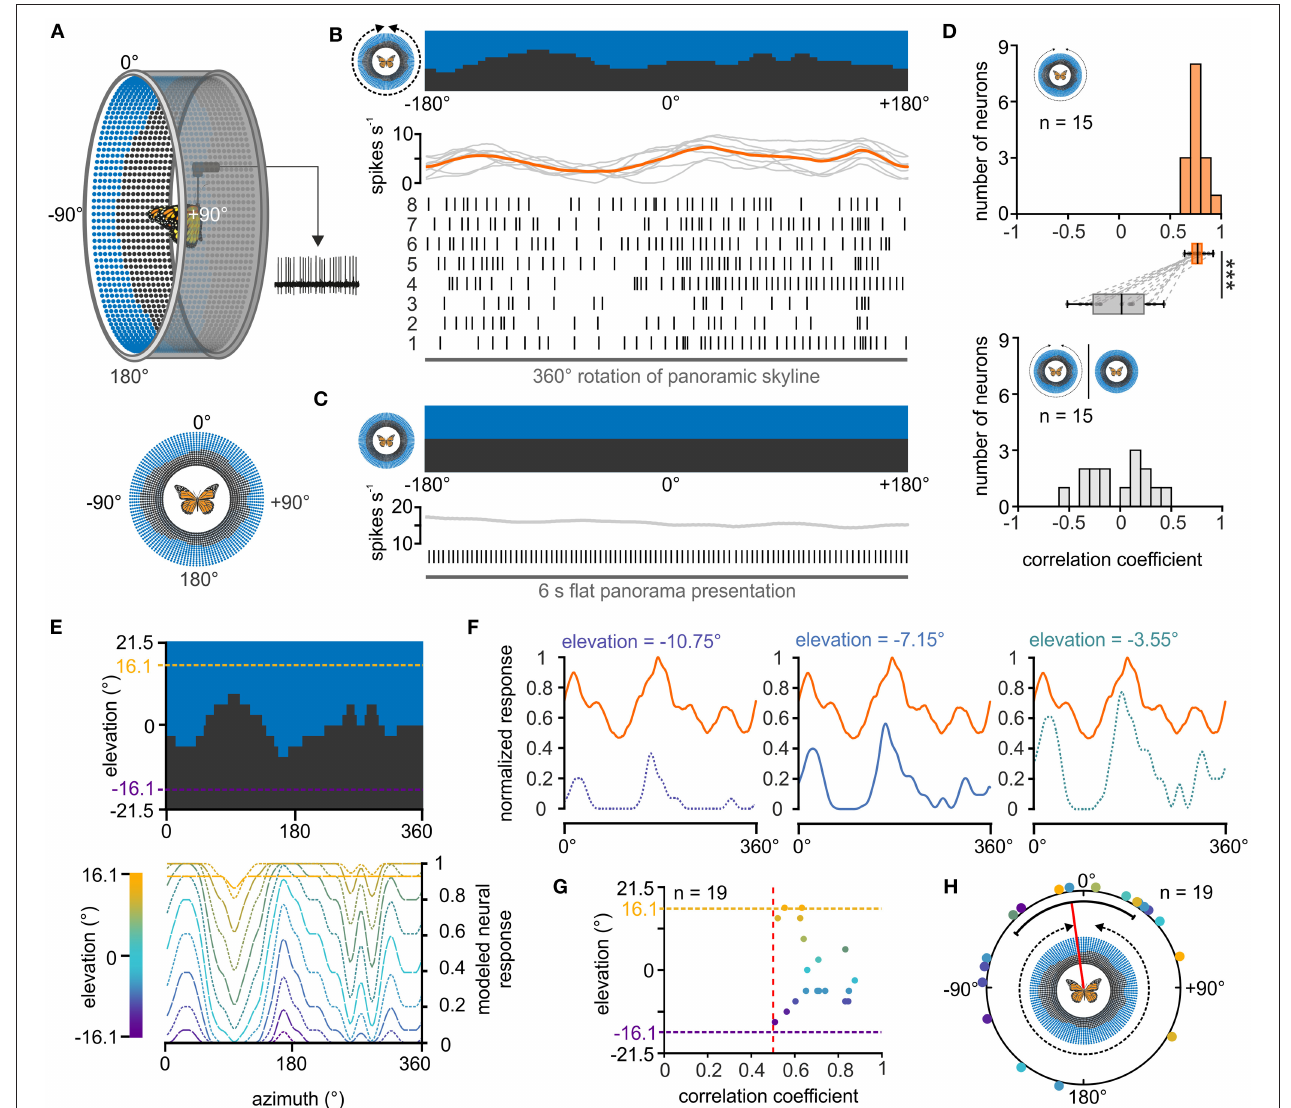
FIGURE 3 | Response of central-complex TL neurons to a panoramic skyline. (A) Schematic drawing of the LED arena (top) that was used to test the coding of a panoramic scene in TL neurons. 0 ◦ was defined as the direction anterior to the butterfly, before the panoramic scene was rotated by 360 ◦ around the animal (bottom). (B) The response of a TL neuron to eight 360 ◦ -rotations of the panoramic scene is shown as raster plot (middle). Each vertical line represents an action potential. The diagram on top shows the sliding window average of the action potentials for the eight rotations (gray curves) as well as their mean (orange curve). The orientation of the panoramic scene prior to rotation is shown (top). (C) The TL neuron does not spontaneously modulate its action potential rate when a flat panorama is presented for 6s. (D) Distribution of correlation coefficients when comparing the neural response from each trial with the averaged response (orange, upper panel) and when comparing the neural response to the flat panorama with the averaged response to the panoramic skyline (gray, lower panel). Box plots: The neurons showed a higher inter-trial modulation to the panoramic scene compared to the modulation to the flat panorama (p < 0.001; sign rank = 120, Wilcoxon signed rank test). Paired data points across the tested groups are connected by dashed lines. Boxes indicate interquartile range. Whiskers extend to the 2.5 th and 97.5 th percentiles. Black horizontal lines show the median. *** p < 0.001. (E) Modeled neuronal response curves to the panoramic skyline of fictive TL neurons that have visual fields centered at different elevations (lower panel). The center of the receptive fields were set for elevations within the panoramic scene (between − 16.1 ◦ and 16.1 ◦ , dashed lines, upper panel). (F) The measured neural response of one recorded TL neuron (orange curve) to the panoramic scene plotted against three modeled neural responses whose visual fields were centered at different elevations [see also lower panel in (E) ]. The measured neural response showed the best match to the modeled modulation at an elevation of − 7.15 (middle plot; correlation coefficient = 0.84). (G) Elevations of the highest match between the measured TL neuron response and the modeled response plotted against the corresponding correlation coefficients. Each point represents an individual TL neuron ( n = 19). Vertical, red dashed line indicates a correlation coefficient of 0.5. The vertical dashed lines represent the elevation range for the modeled receptive fields (between − 16.1 ◦ and 16.1 ◦ ). (H) Azimuthal shifts leading to the maximum correlation between the measured and modeled neural response are plotted for each neuron ( n = 19). Shifts were clustered in the frontal visual field ( p = 0.045; Z = 3.06, n = 19, Rayleigh test). The mean is indicated by a red solid line and the confidence intervals (95%) by a black arc. The color code of the individual TL neurons in G and H corresponds to the color code of the heatmap in (E) .